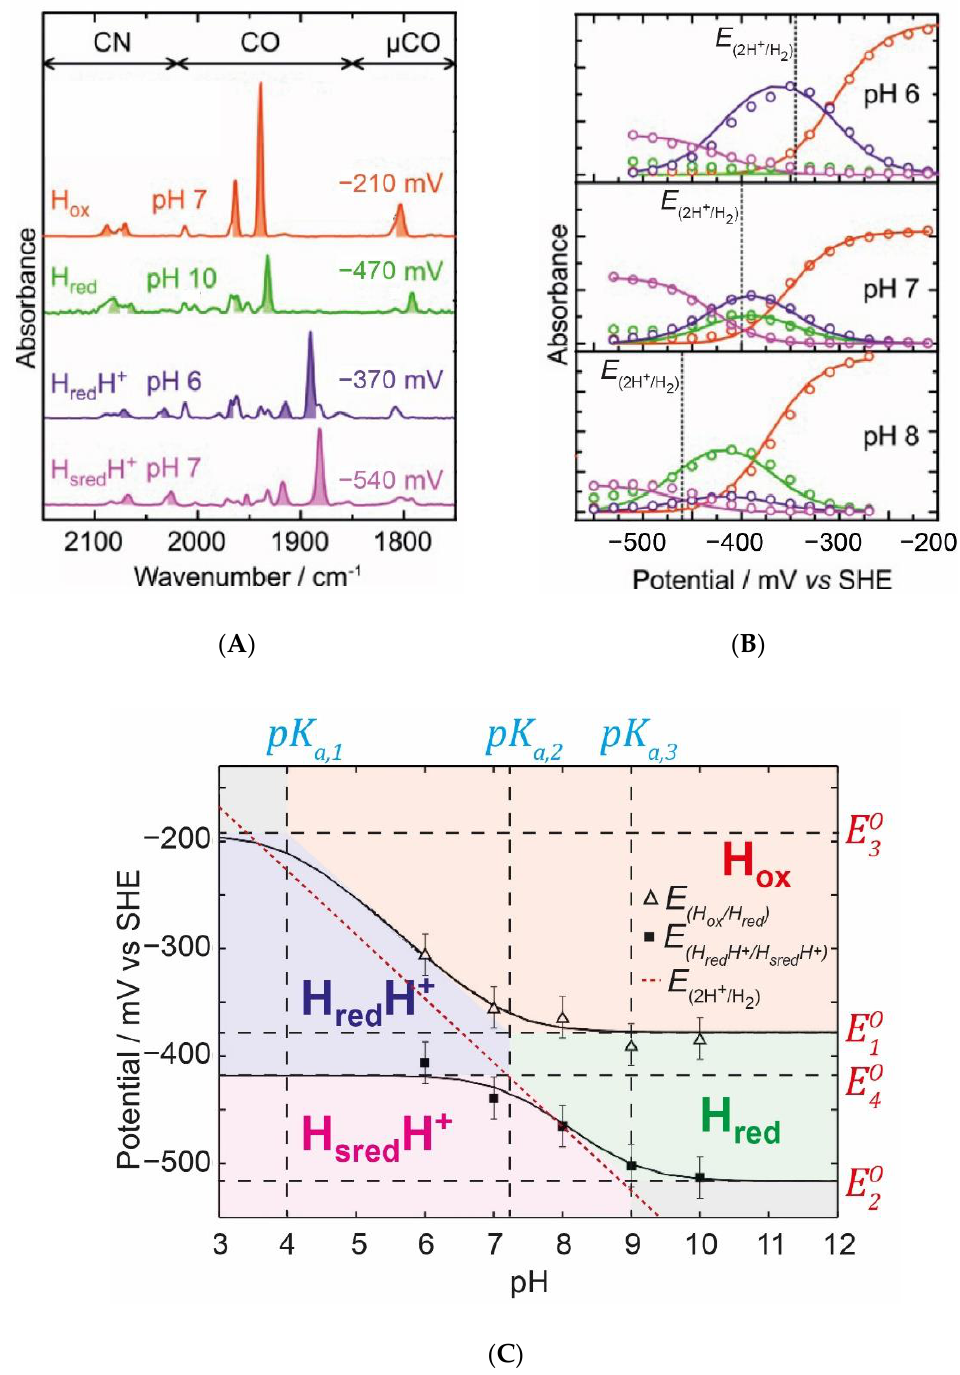
Figure 10. Application of the simple model for [FeFe] hydrogenase to experimental IR spectro-electrochemical data. ( A ) IR spectra recorded at various pH values and applied potentials, measured at 288 K. ( B ) Reductive titrations obtained from the IR spectro-electrochemical data. The dotted black lines represent the thermodynamic potential for the 2H + /H 2 couple at each pH. ( C ) The Pourbaix diagram showing the regions with respect to pH and applied potential ( E ) where each of the four states ( H ox , H red , H red H + , and H sred H + ) dominates. The grey areas in the top left and bottom right corners represent the areas where the H ox H + and H sred species are expected to be observed. However, these have not yet been seen experimentally. The thermodynamic potential of the 2H + /H 2 couple is plotted vs. pH (red dotted line) for comparison. Adapted with permission from [35]. Copyright 2017 American Chemical Society.